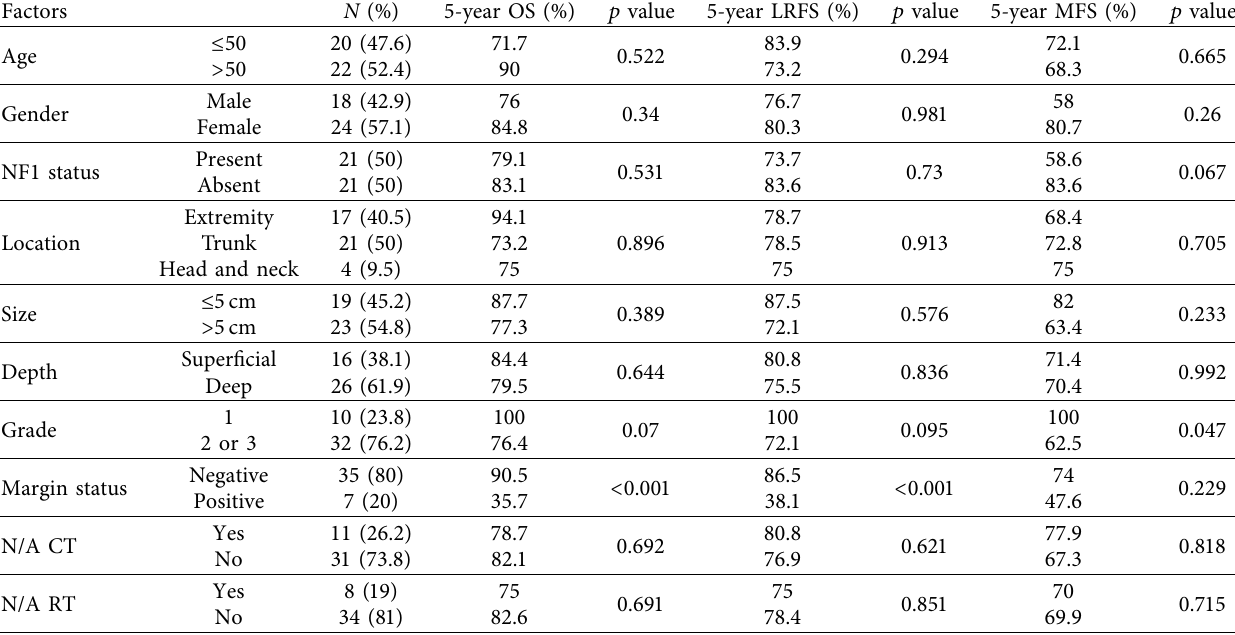
Table 3: Patient-, tumour-, and treatment-related characteristics and univariate analysis of prognostic factors for OS, LRFS, and MFS in 42 patients with nonmetastatic MPNST who underwent surgery of the primary tumour at our institutions.